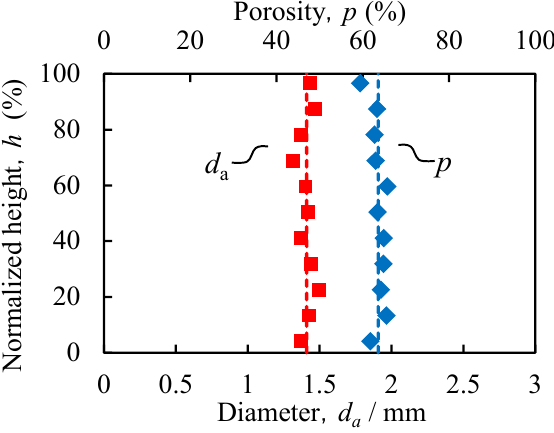
Figure 7. Relationship between specimen height and average diameter d a of pores porosity p .